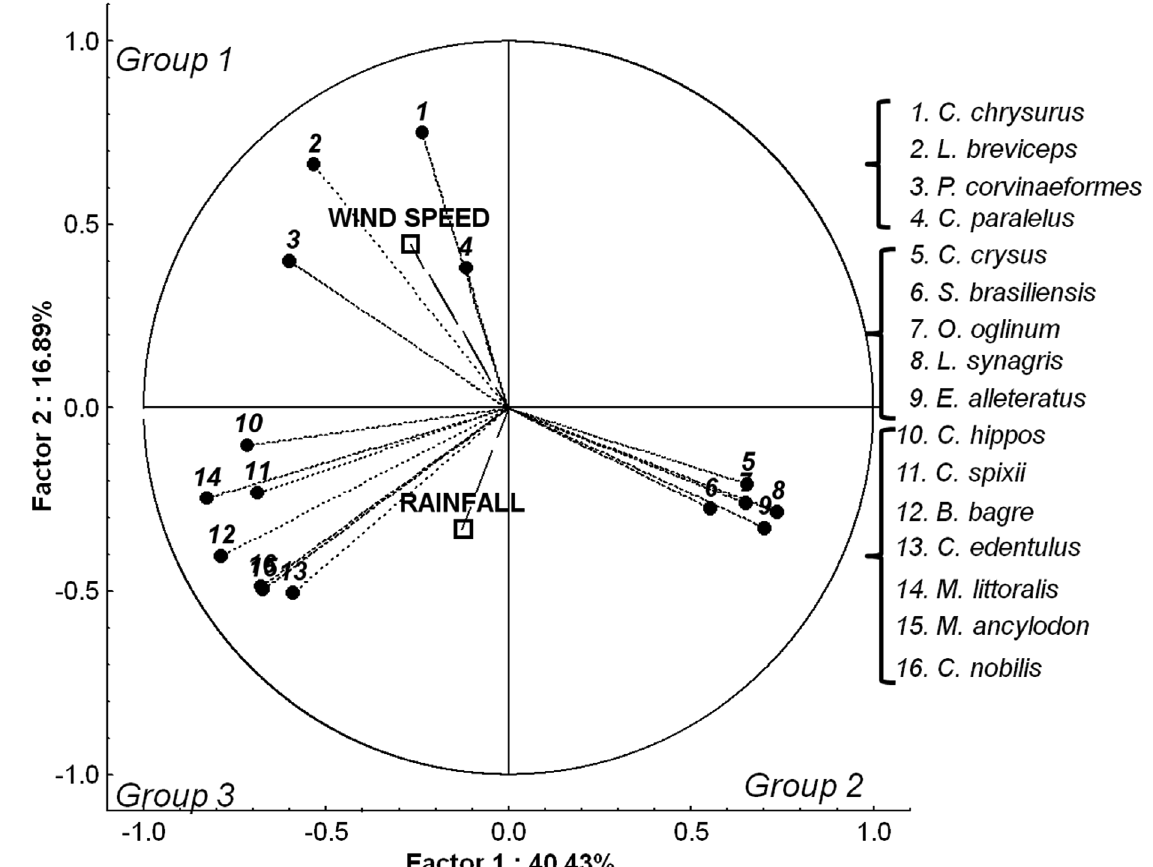
Figure 11. PCA of species abundance associated to precipitation and wind